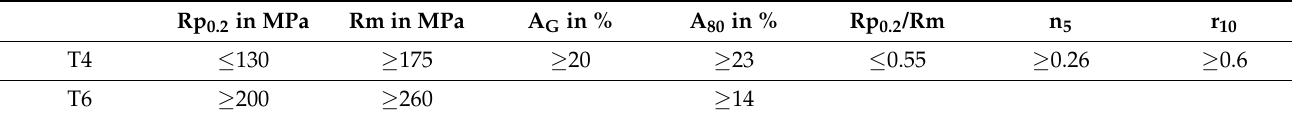
Table 3. Mechanical properties of EN AW 6014 [18]